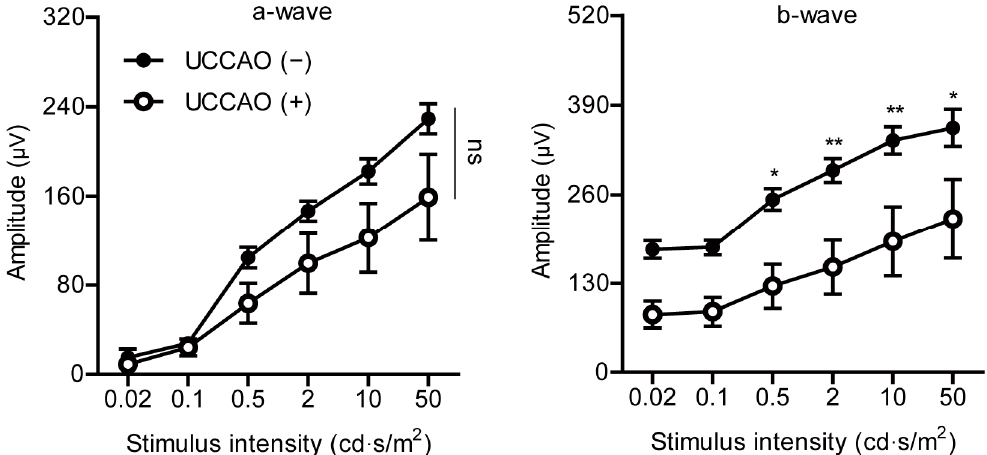
in the amplitude of b-wave in the UCCAO-operated eye 7 days after UCCAO. * p < 0.05, ** p < 0.01. The data were ana-